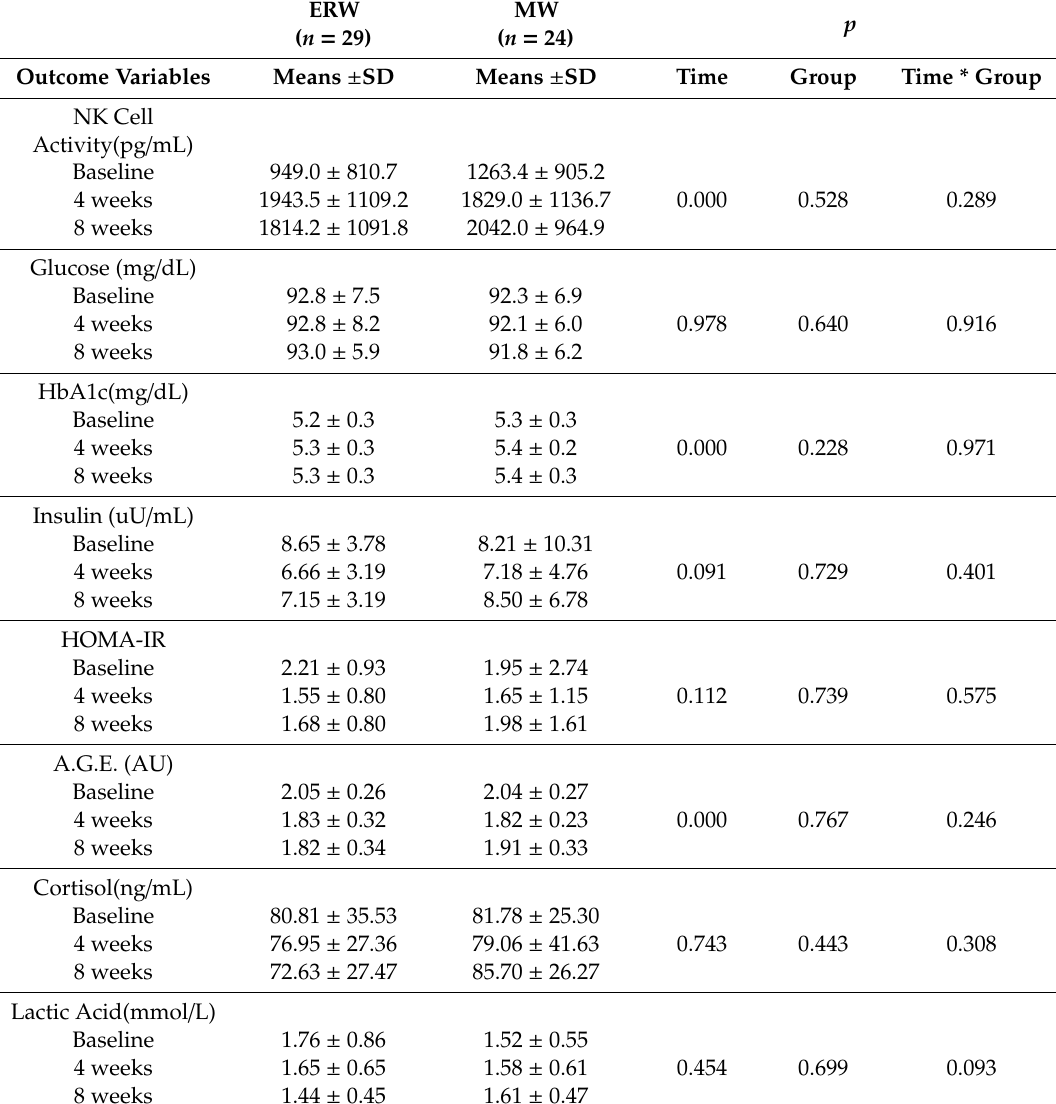
Table 3. E ff ects of treatment on the secondary outcome variables: biochemistry